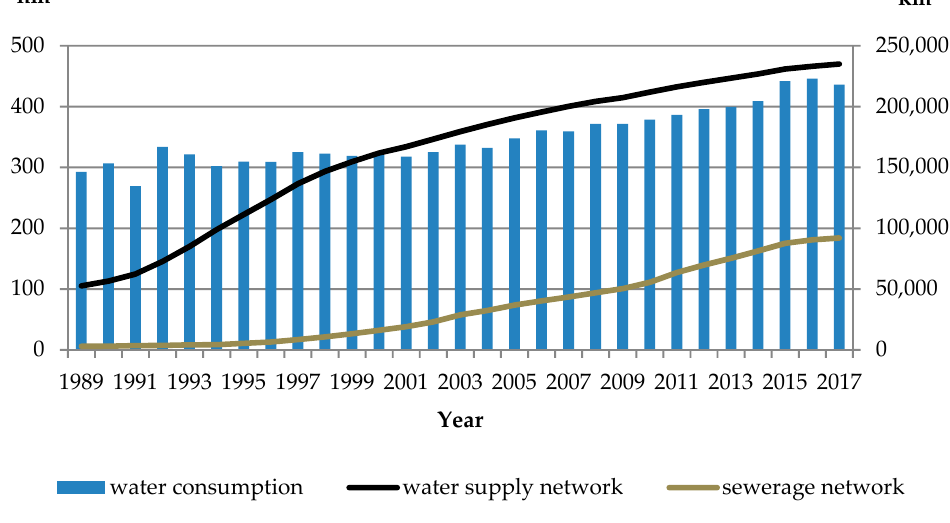
Figure 1. Water consumption and length of sewerage and water supply networks in rural Poland.